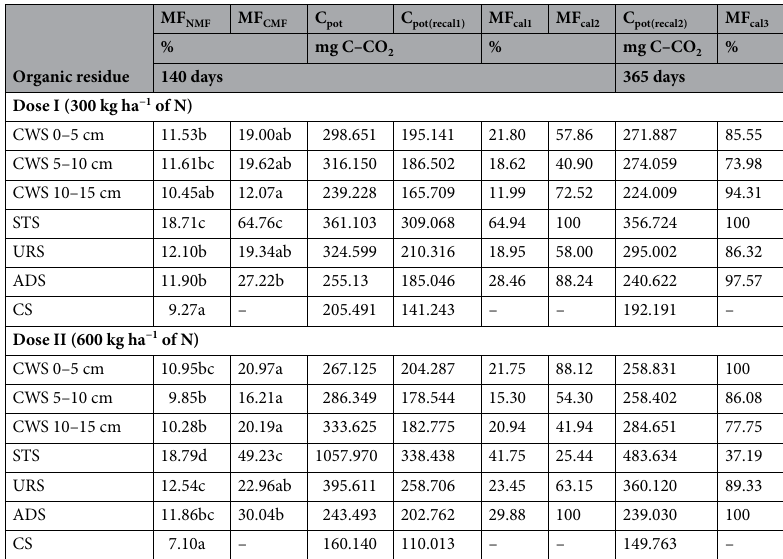
Table 2. Net mineralization fraction (NMF), complementary mineralization fraction (CMF) and estimated mineralization fraction (MF CAL1 , MF CAL2 ) obtained from the adjusted parameters in the two simultaneous phase kinetic equation, for data of the organic residues and control soil at the doses of 300 kg ha -1 of N and 600 kg ha -1 of N, monitored during the 140 day period. MF (cal3) , calculated in accordance with MF (cal2) but for the period of 365